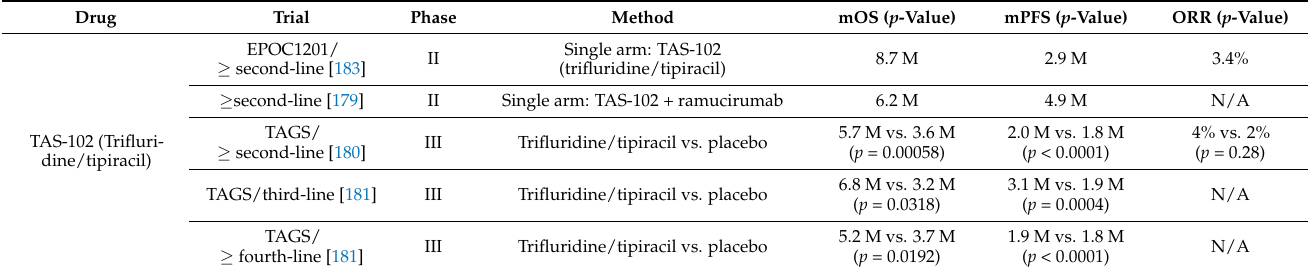
Table 5. Phase II and III trials of therapies targeting DNA synthesis. mOS, median overall survival; mPFS, median progression-free survival; HR, hazard ratio; M, months; ORR, objective response rate.